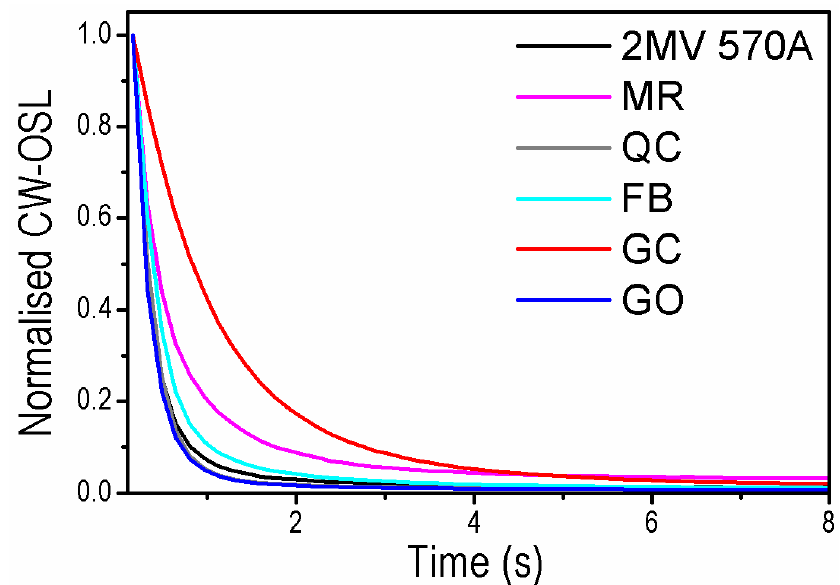
Figure 2. CW-OSL 470 nm curves measured for one aliquot of each sample after irradiation with a dose of 1000 Gy and preheat up to 240 °C. Data set after normalization to the initial intensity. The blue LEDs were used for the optical stimulation with 90% of their maximal power ~80 mW/cm 2 .